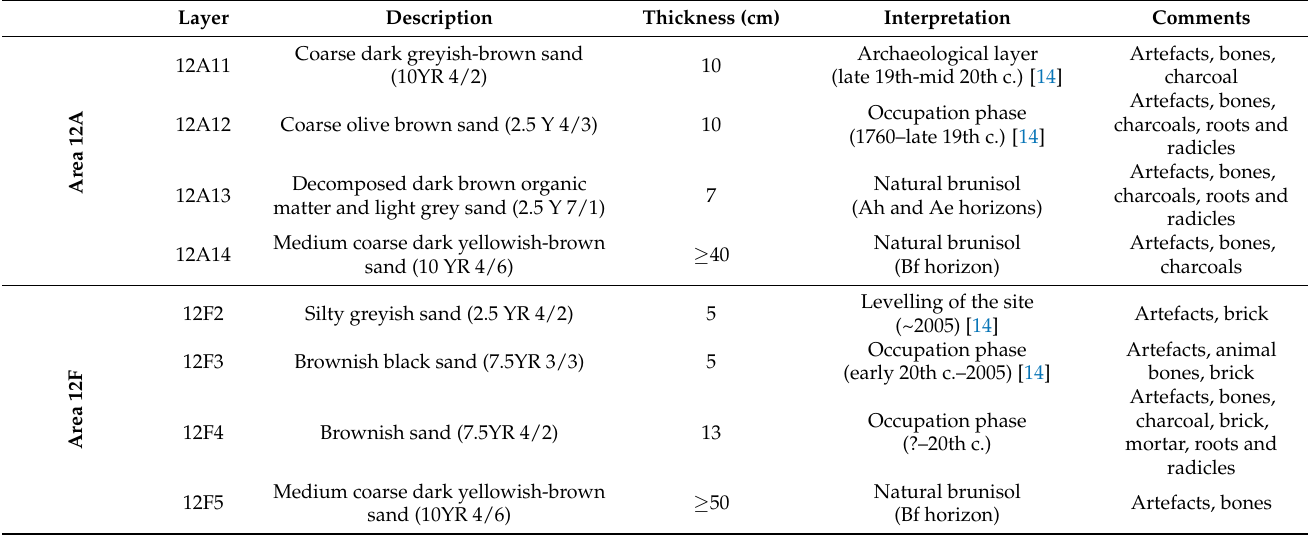
(10YR 4/2): from Munsell soil color